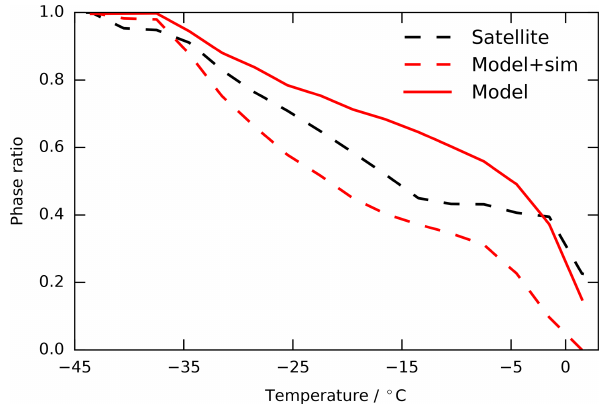
Figure 8. Cloud phase ratio per temperature for histogram bin widths of 3 ◦ C. The average ice fraction per temperature bin is shown for the model data (red, solid line), the CALIPSO-GOCCP product (black, solid line) and the output from the COSP simula- tor applied to the model (red, dashed line). For both the model and satellite data we assumed that clouds with undefined phase as clas- sified by the lidar simulator or retrieval algorithm are dominated by ice and thus contribute to the ice phase (Cesana et al.,